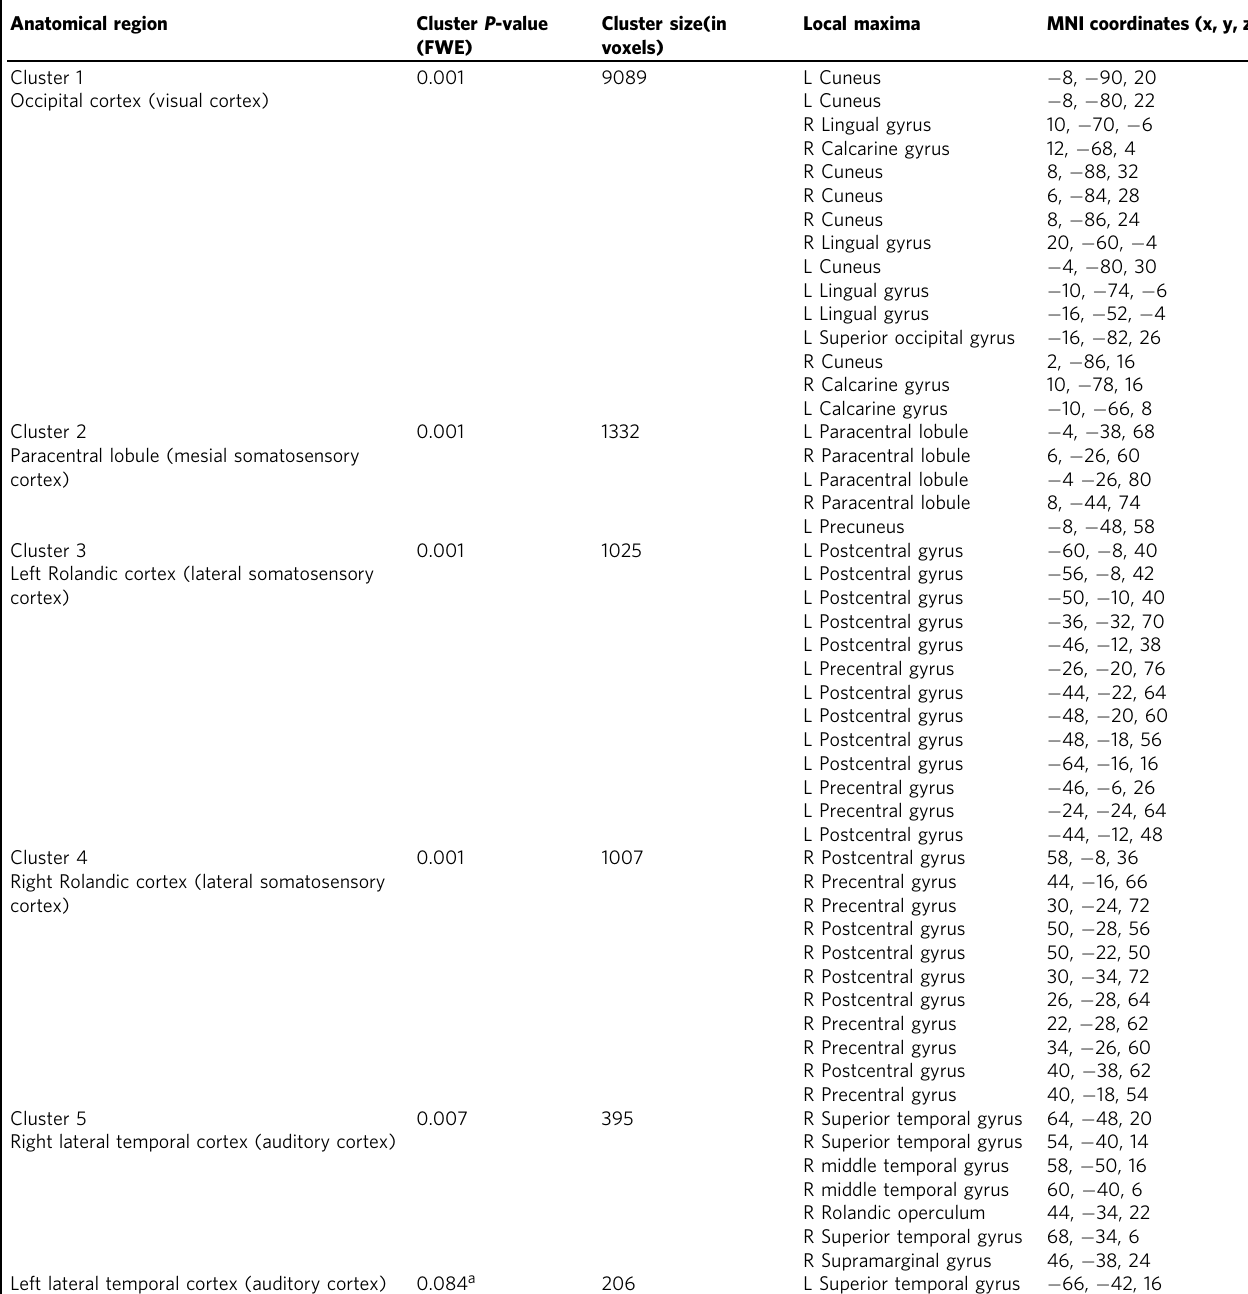
Cluster size(in Local maxima MNI coordinates (x, y, z) (FWE) voxels)